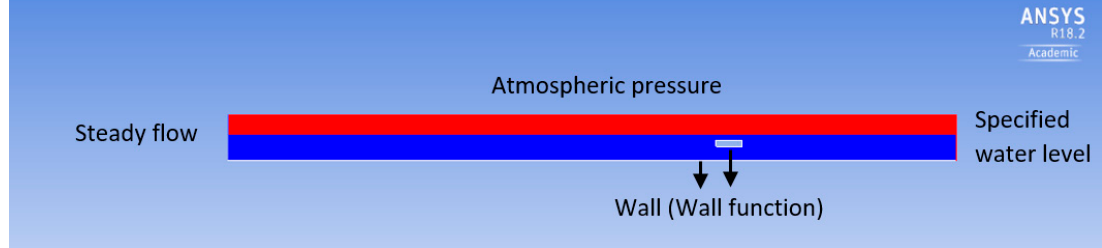
Figure 14. Boundary conditions of the numerical simulation.